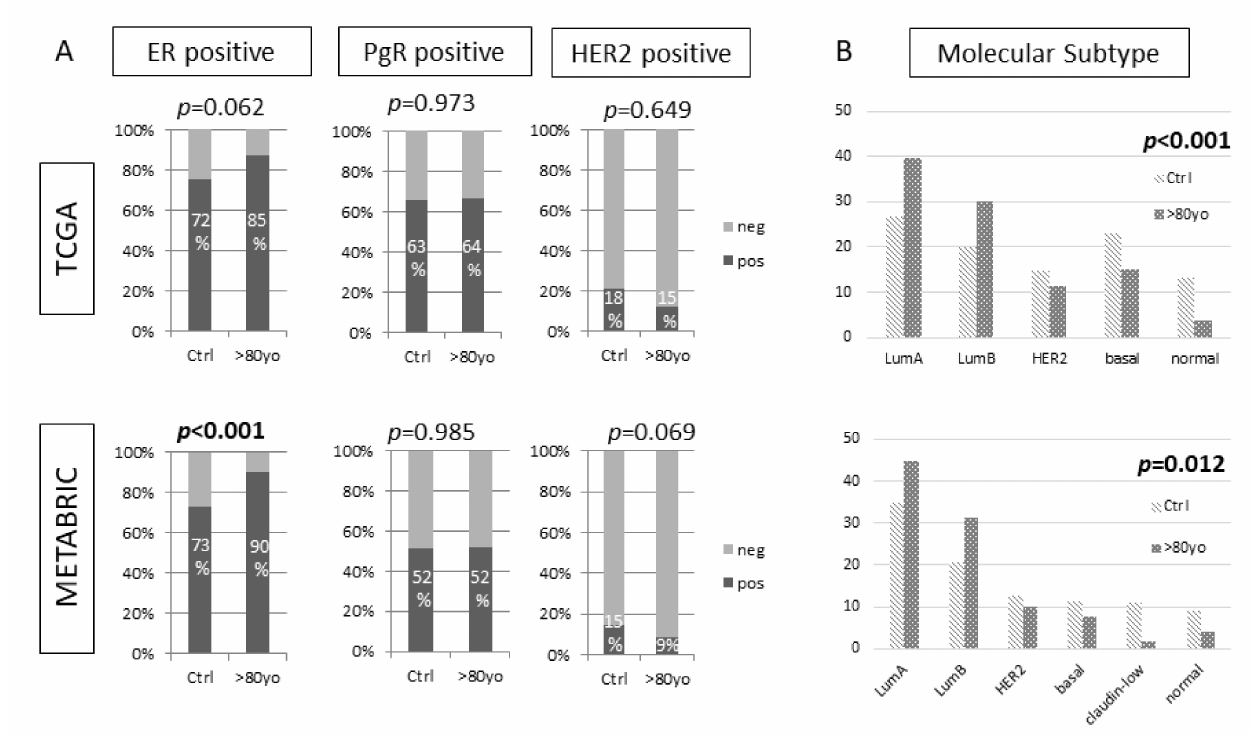
Figure 1. Expression rate of receptors and intrinsic subtype in TCGA and the METABRIC cohorts. ( A ) Comparison of the positive expression rate of receptors in the control group versus the octogenarian group. ( B ) Comparison of the PAM50 intrinsic subtypes by gene expression in the control group versus the octogenarian group. There was a statistically significant difference between the control group and the